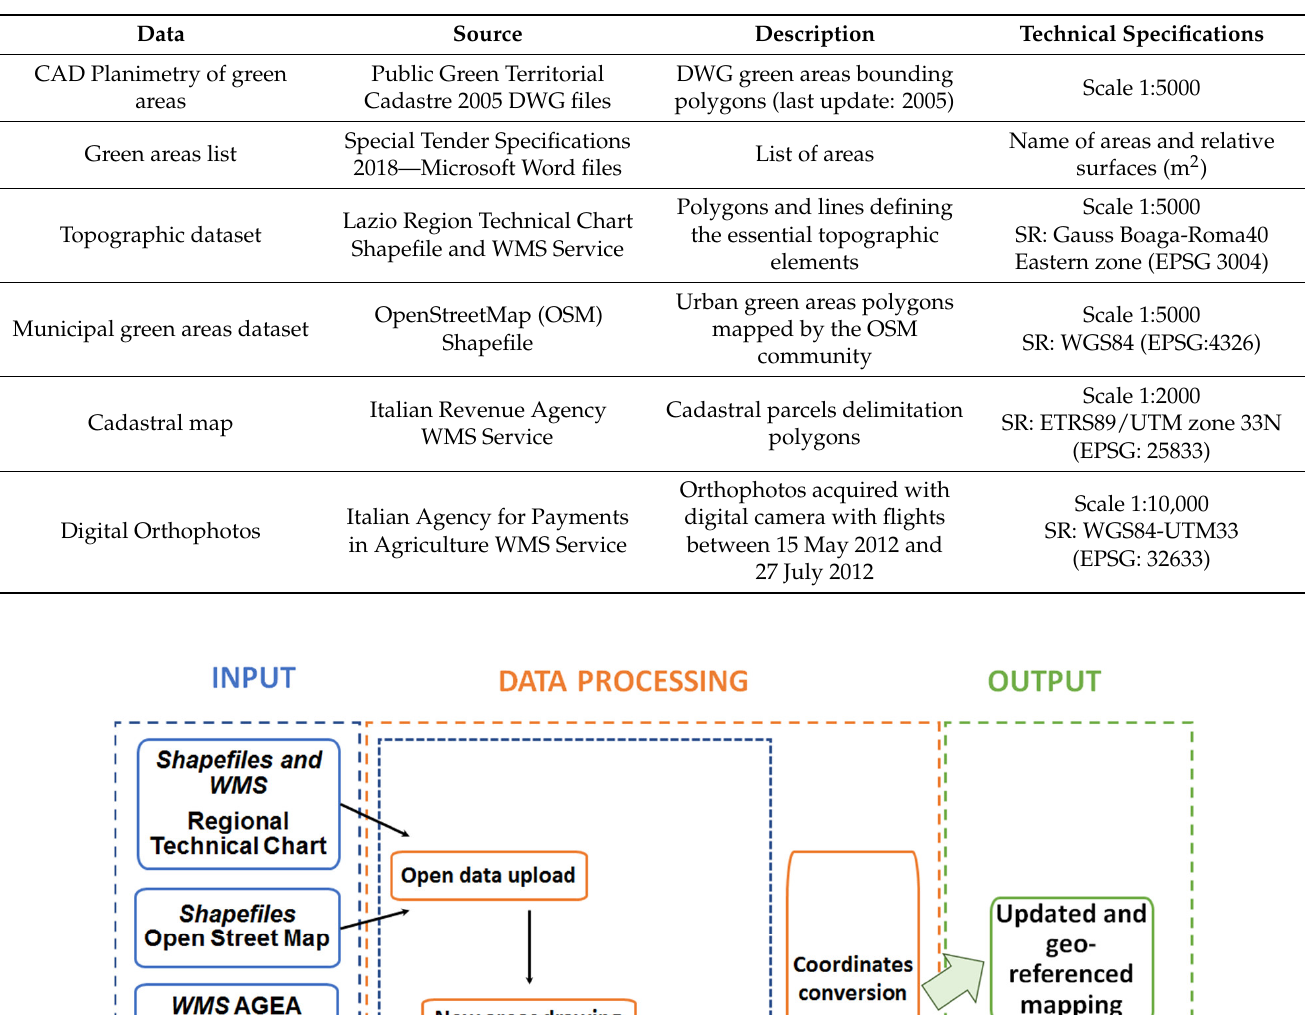
Table 2. Source data for GIS mapping.